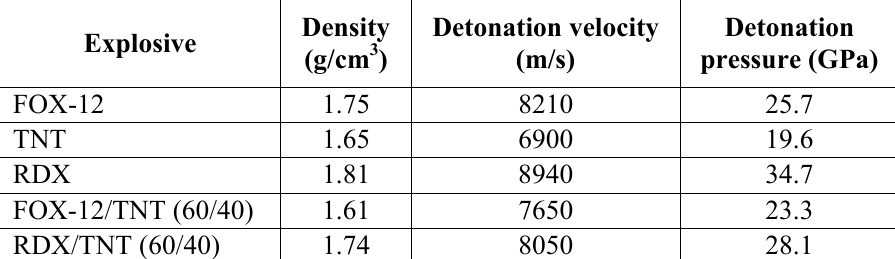
Table 2. Calculated characteristics